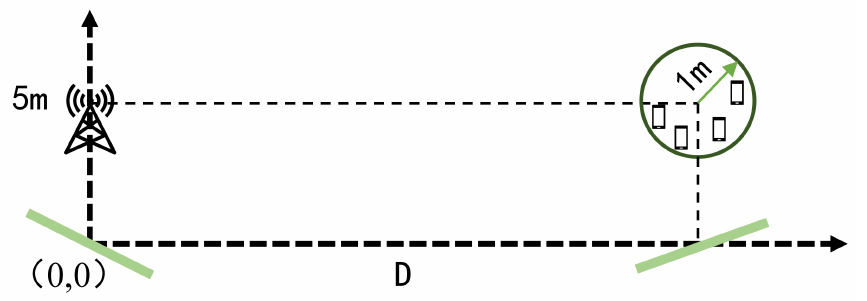
Figure 2. The simulated cooperative IRS-assisted multi-user communications.